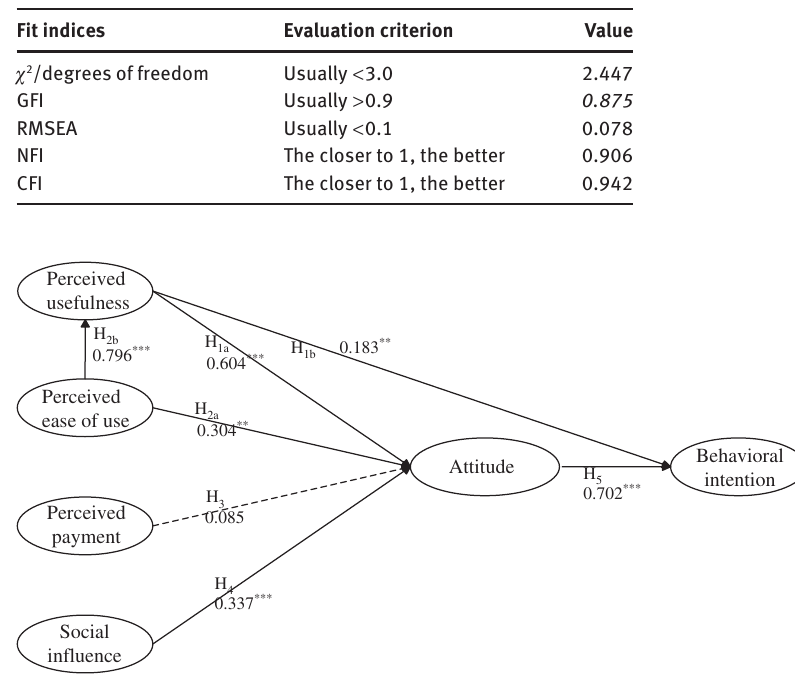
Figure 2. Path Coefficients in Mobile